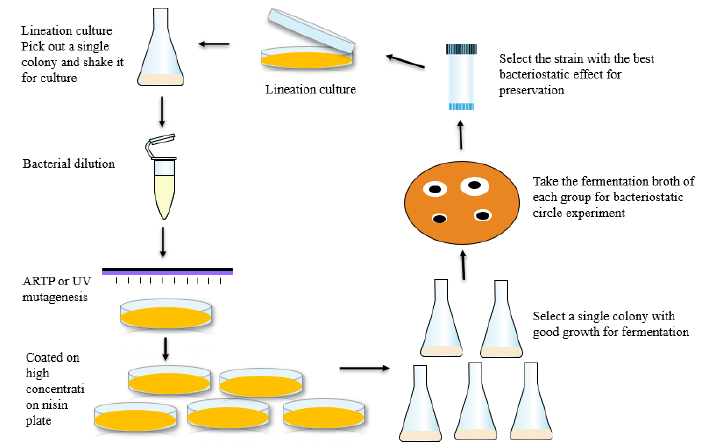
Figure 1. Compound mutation and breeding process.